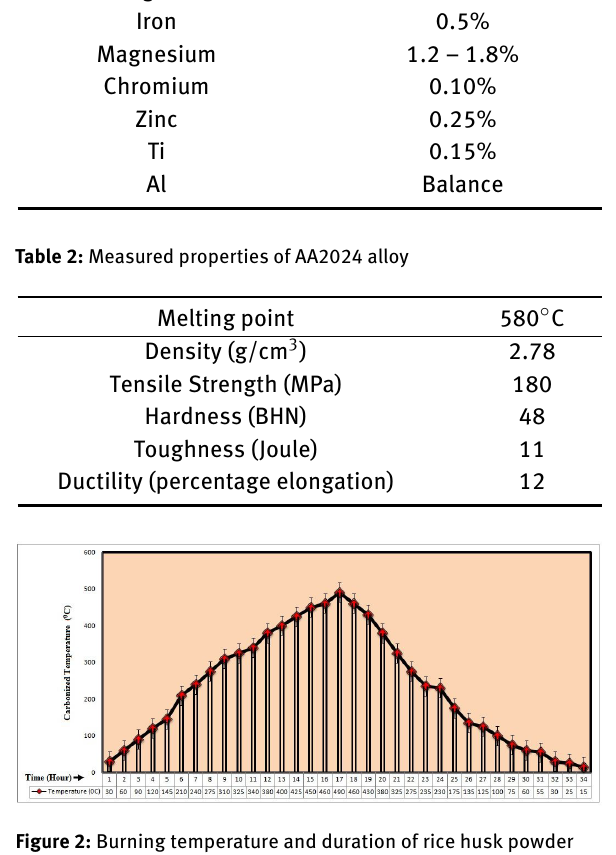
Figure 2: Burning temperature and duration of rice husk powder (RHP) to convert rice husk ash (RHA) the main alloying element. Machining property of AA2024 alloy is average, while its corrosion resistance property is very low. It is very tough to weld. It is broadly used in air- craft industries in making wing and fuselage structures under simple tension due to its high fatigue and tensile strength. Its chemical compositions and mechanical prop- erties are shown in Table 1 and Table 2 respectively.